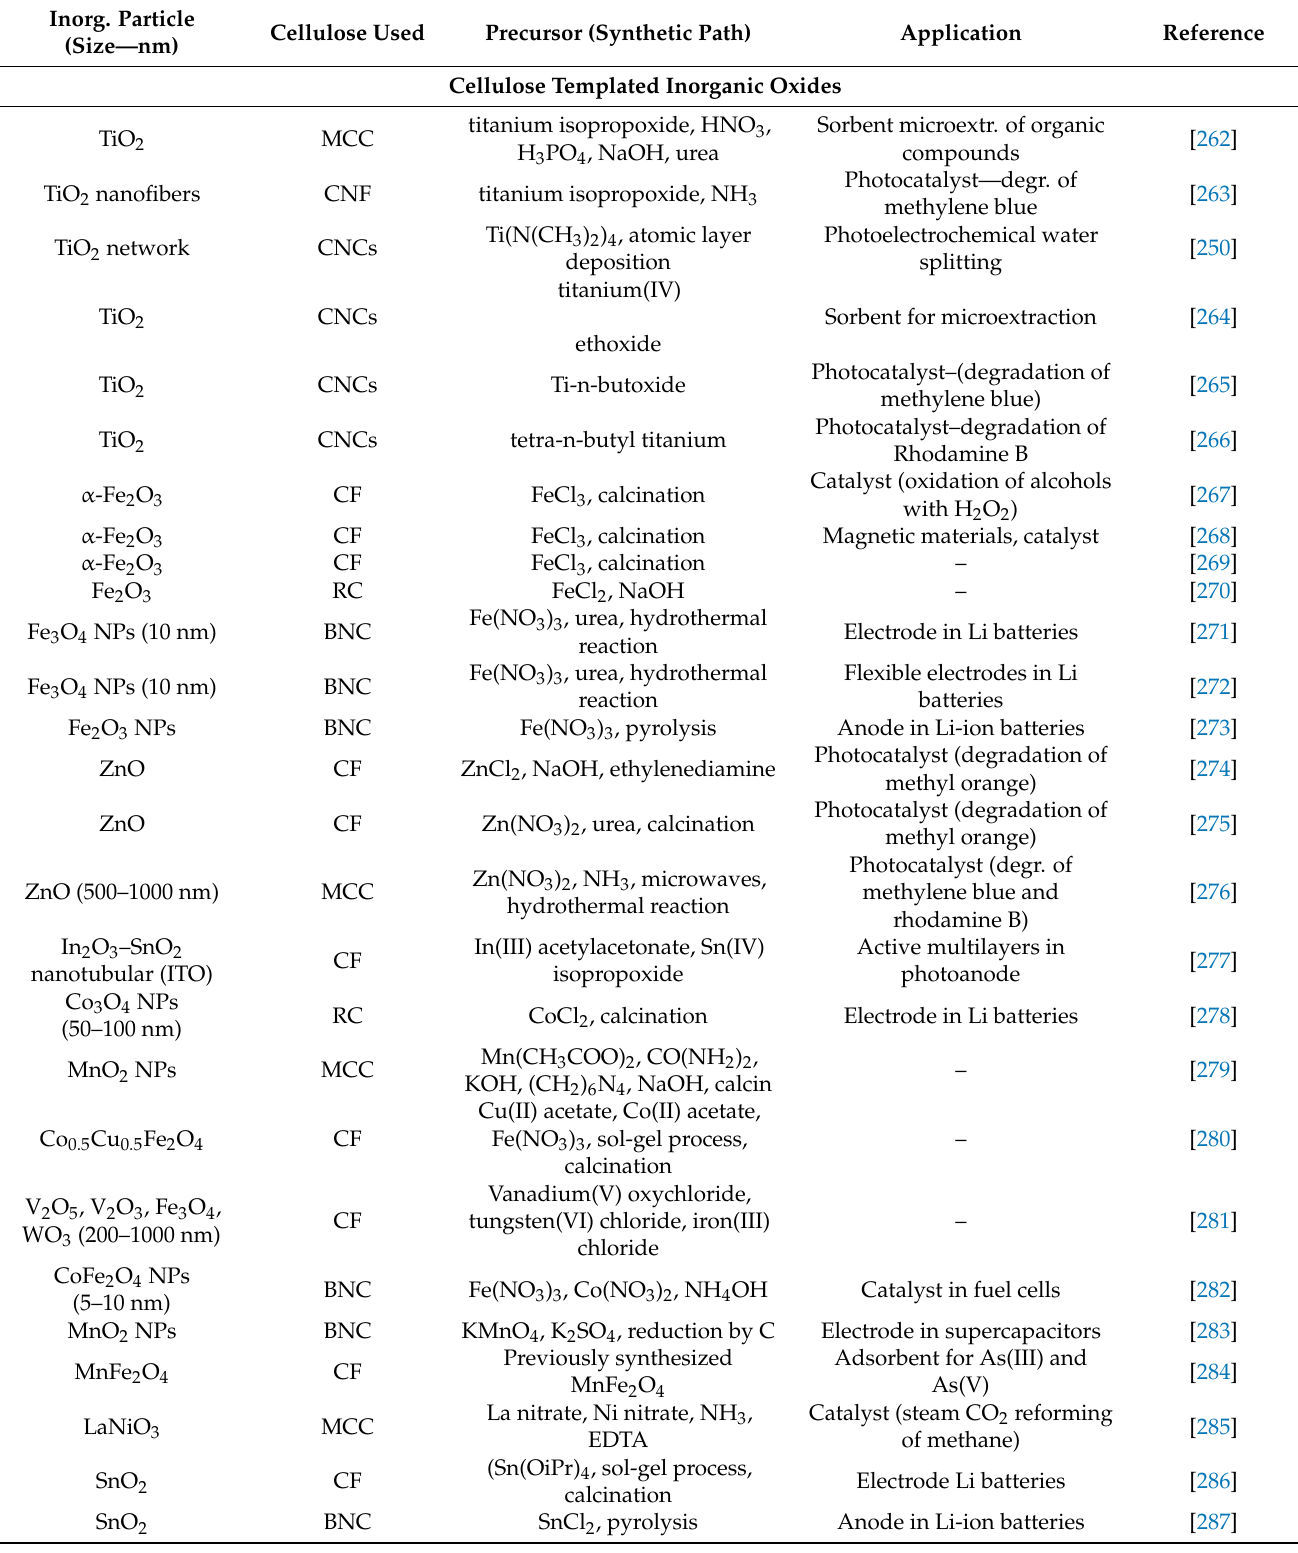
Table 4. The list of publications on cellulose-templated porous metal oxide structures or metal oxide nanostructures supported by carbon fibers formed from cellulose structures. The list is organized from large cellulose structures (CF and RC) via the microstructured celluloses (MCC and MFC) to the nanostructured celluloses (BNC and